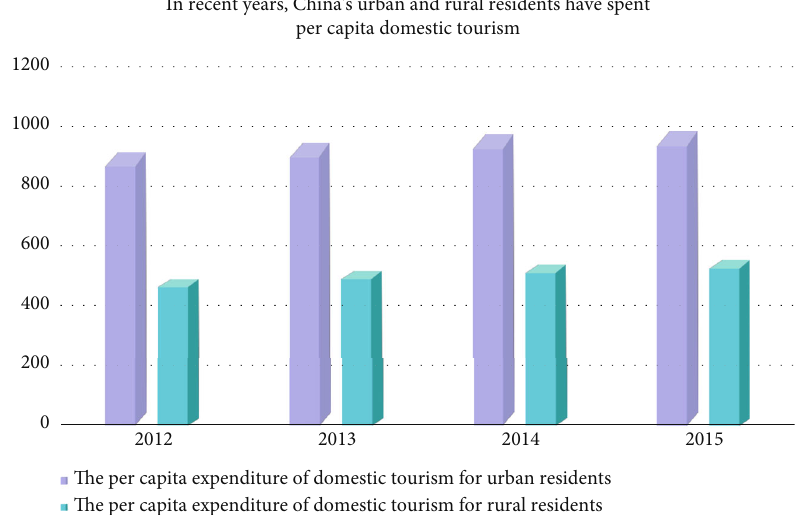
Figure 7: The per capita domestic tourism expenditure of Chinese urban and rural residents in recent